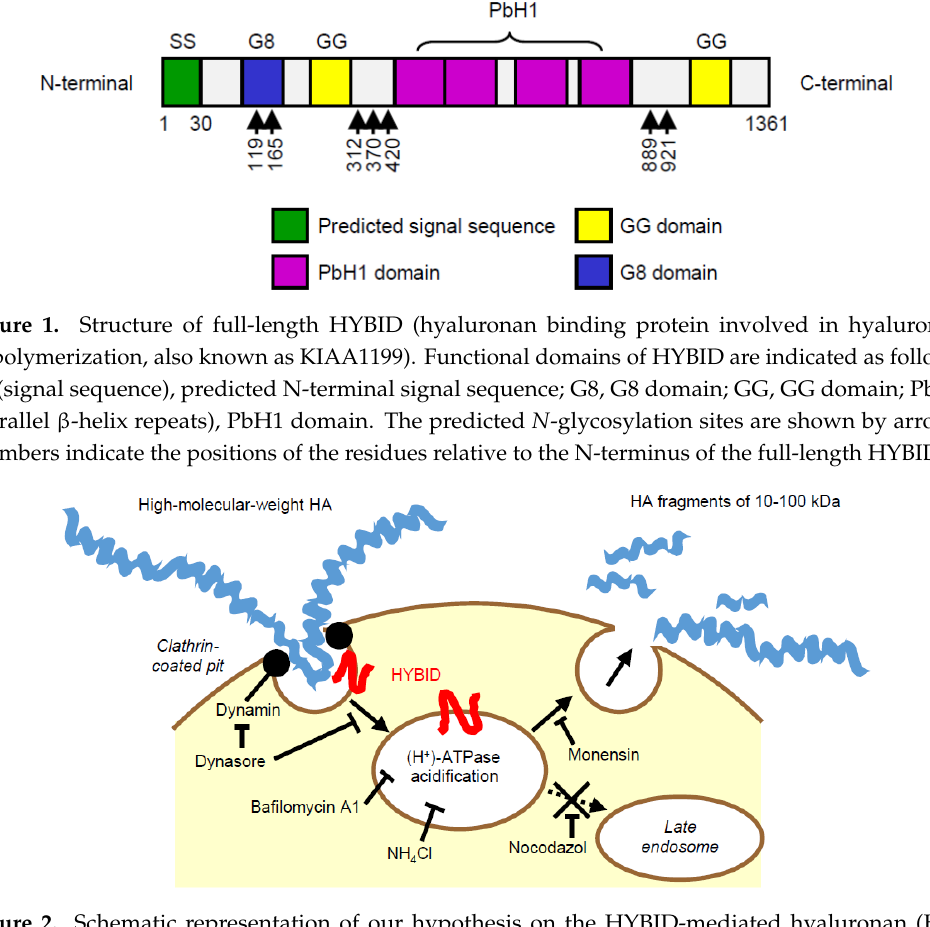
Figure 2. Schematic representation of our hypothesis on the HYBID-mediated hyaluronan (HA) degradation. High-molecular-weight HA is endocytosed to clathrin-coated vesicles, and cleaved to lower-molecular-weight HA fragments by the action of HYBID in acidic compartments. Then, the fragments are released extracellularly without intracytoplasmic